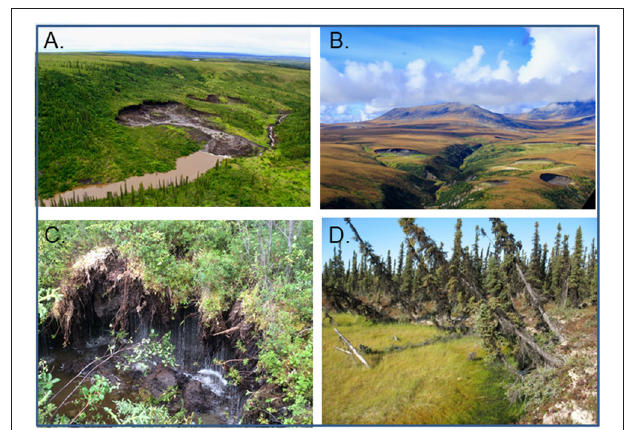
FIGURE 3 | Thermokarst processes affecting the storage and delivery of water and carbon across boreal landscapes. These include: (A) thaw slumps and enhanced particulate matter to stream input and (B) collapse and drainage features on the Peel Plateau, Northwest Territories, Canada, (C) active thermally-driven erosion pervasive in the Erickson Creek watershed, Alaska, USA, and (D) subsidence and bog formation in Innoko Flats, Alaska, USA. Photo credits: Scott Zolkos, Woodwell Climate Research Center (A and B) ; Kim Wickland, U.S. Geological Survey (D) .